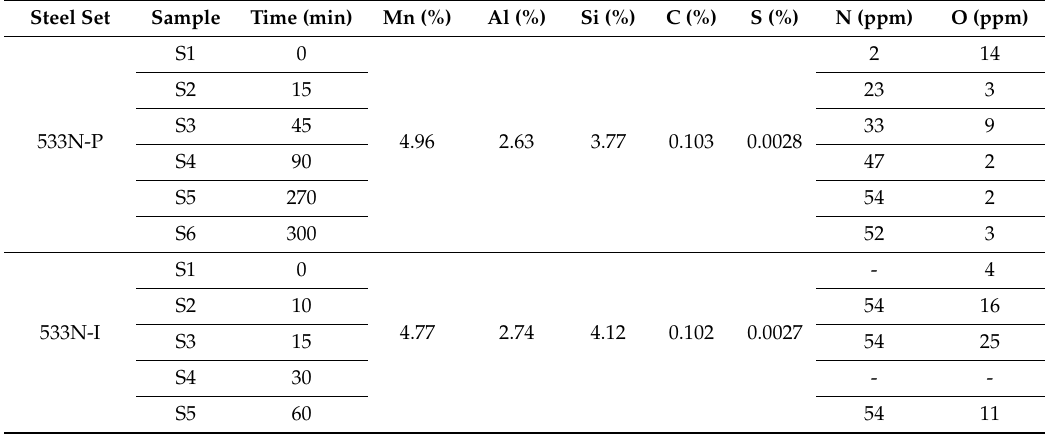
Table 2. The chemical composition of the steel